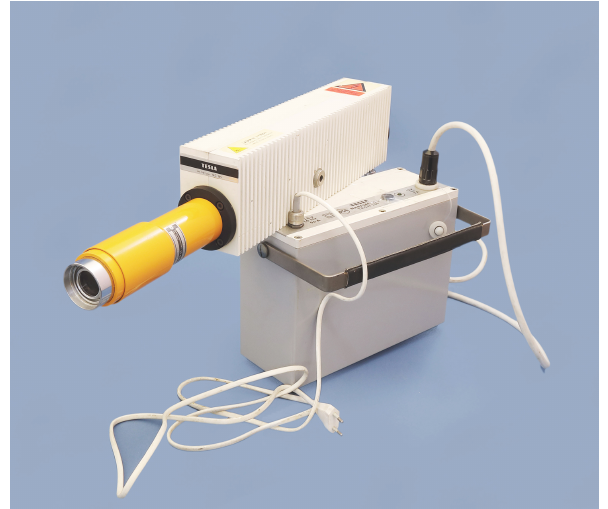
Figure 11. Layout Laser TKG 205 by Tesla company (photo sup- plied by